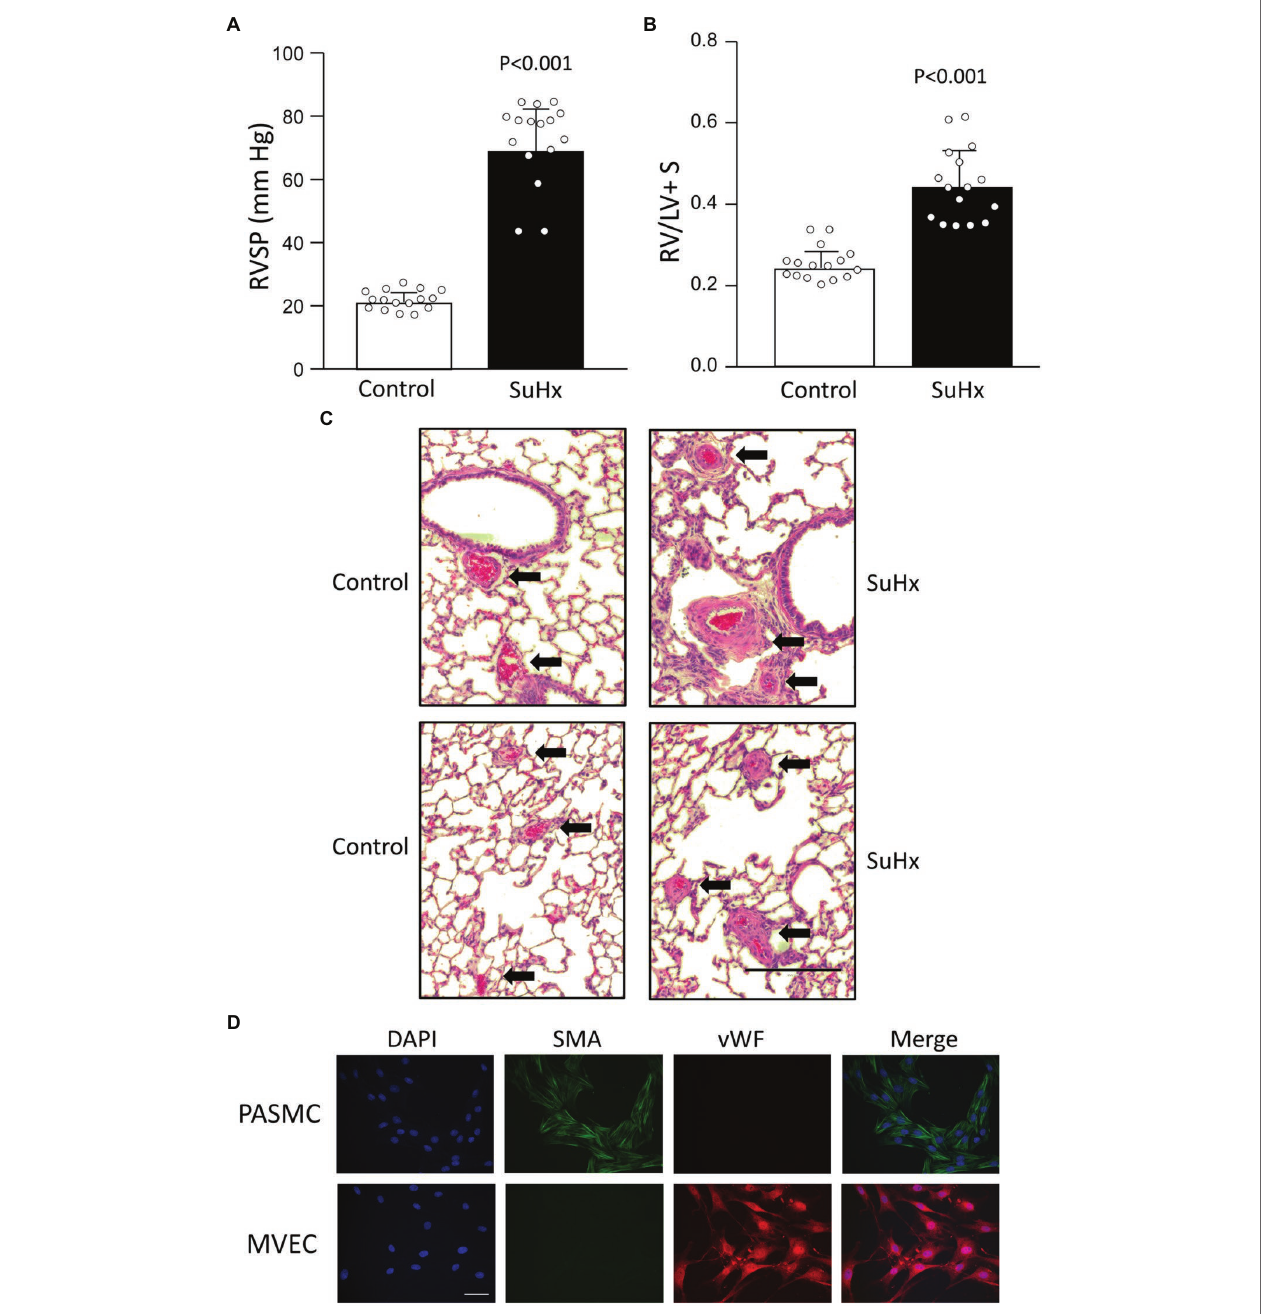
FIGURE 1 | Validation of model. Bar graphs showing mean ± SD values for (A) right ventricular systolic pressure (RVSP) and (B) right ventricle (RV) to left ventricle plus septum (LV + S) weight ratio in control and SuHx rats. Each dot represents a single animal. Value of p determined by t -test. (C) Representative histology images (H&E staining) illustrating vascular remodeling in SuHx rats. Dark red blood cells are clearly evident within vessels. Arrows point to arteries (top) and small vessels (bottom); bar indicates 200 μ m. (D) Representative images showing immunofluorescence for DAPI (nuclei), smooth muscle-specific α -actin (SMA), von Willebrand factor (vWF), and the merged image for pulmonary arterial smooth muscle cells (PASMCs) and MVECs isolated from control rats. Scale bar indicates 50 μ m. Results representative of those obtained in at least 10